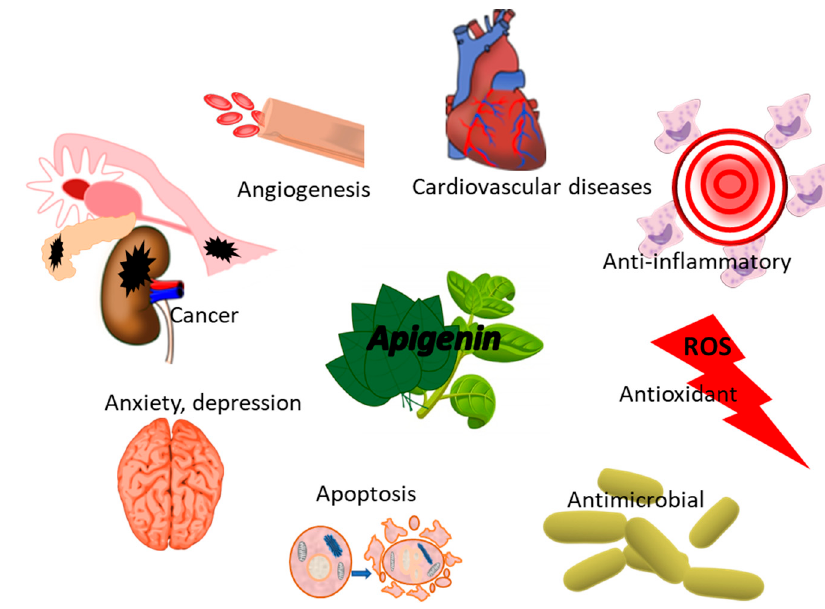
Figure 6. Biological activity of apigenin for human wellness.